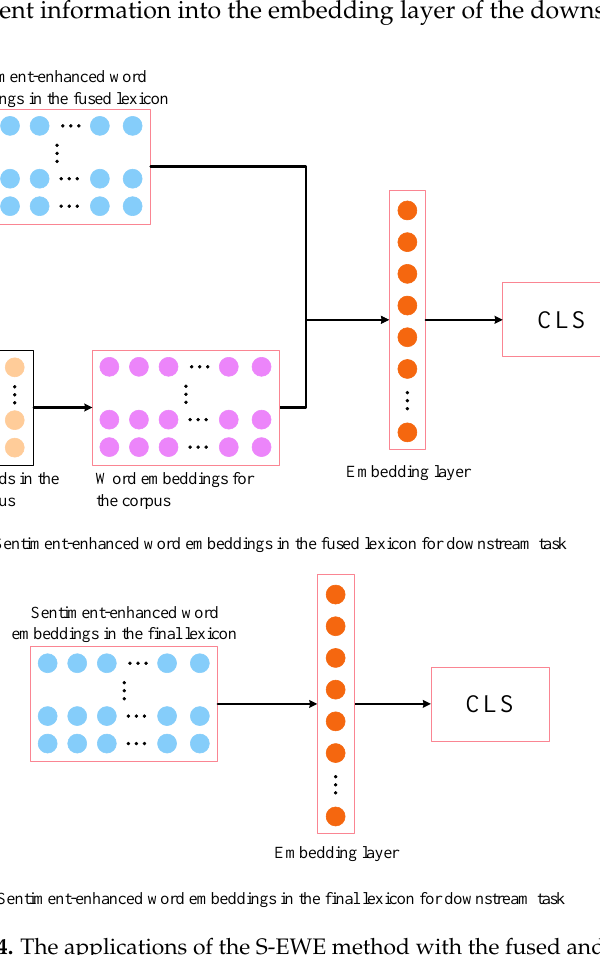
Figure 4. The applications of the S-EWE method with the fused and final lexicons on downstream